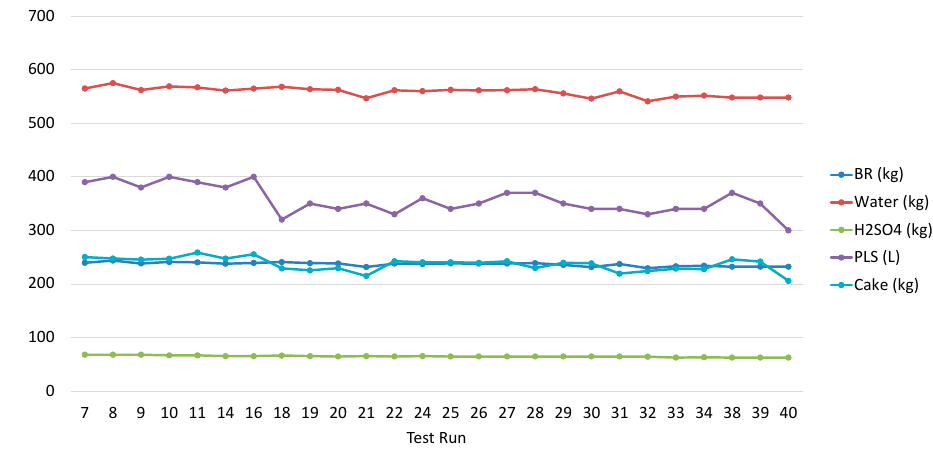
Figure 3. Leaching pilot data of inputs (BR, water, H 2 SO 4 ) and outputs (PLS, filter cake).